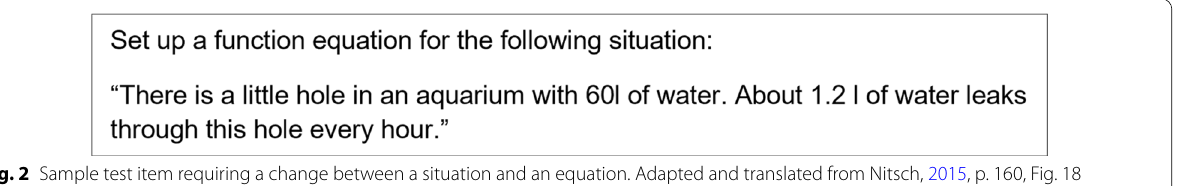
Fig. 2 Sample test item requiring a change between a situation and an equation. Adapted and translated from Nitsch, 2015, p. 160, Fig. 18 (adapted and translated by permission from Springer Nature Customer Service Centre GmbH: Springer, Diagnose von Lernschwierigkeiten im Bereich funktionaler Zusammenhänge by R. Nitsch, ©